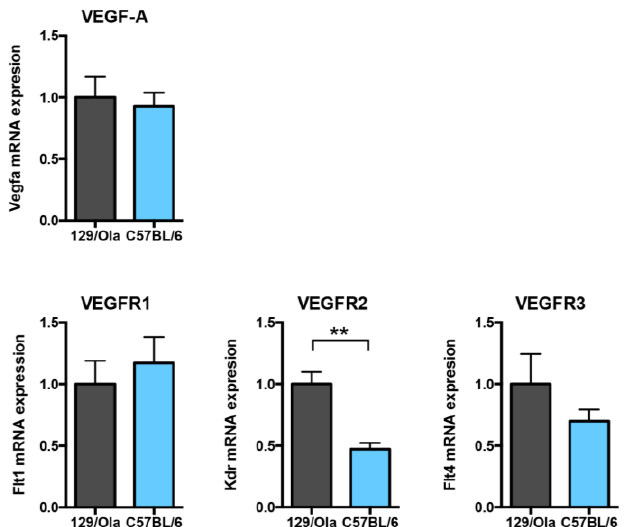
Figure 6. mRNA levels of the Vascular Endothelial Growth Factor (VEGF) signaling pathway in the livers of WT mice of 129/Ola and C57BL/6 genetic backgrounds. Quantification of the mRNA expression level of Vegfa (VEGF-A) and its three receptors Vegfr2, Flt1 (VEGFR1), and Flt4 (VEGFR3) from the livers of the 129/Ola and the C57BL/6 mice (n = 4 – 5 and n = 6, respectively). Values are normalized to the Rpl13a mRNA expression levels and the results are expressed as a ratio of these values to that of 129/Ola (∆∆Ct method). Data are plotted as mean ± SEM. Statistical analysis was performed using the Mann – Whitney test. ** p < 0.01.